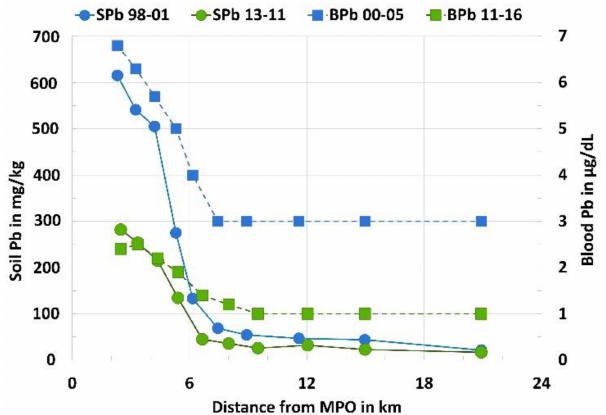
Figure 1. Soil Pb (circles with scale on the left) and blood Pb (squares with scale on the right) medians as a function of distance sectors from the Main Post Office (MPO) for the 1998–2001 soil surveys.